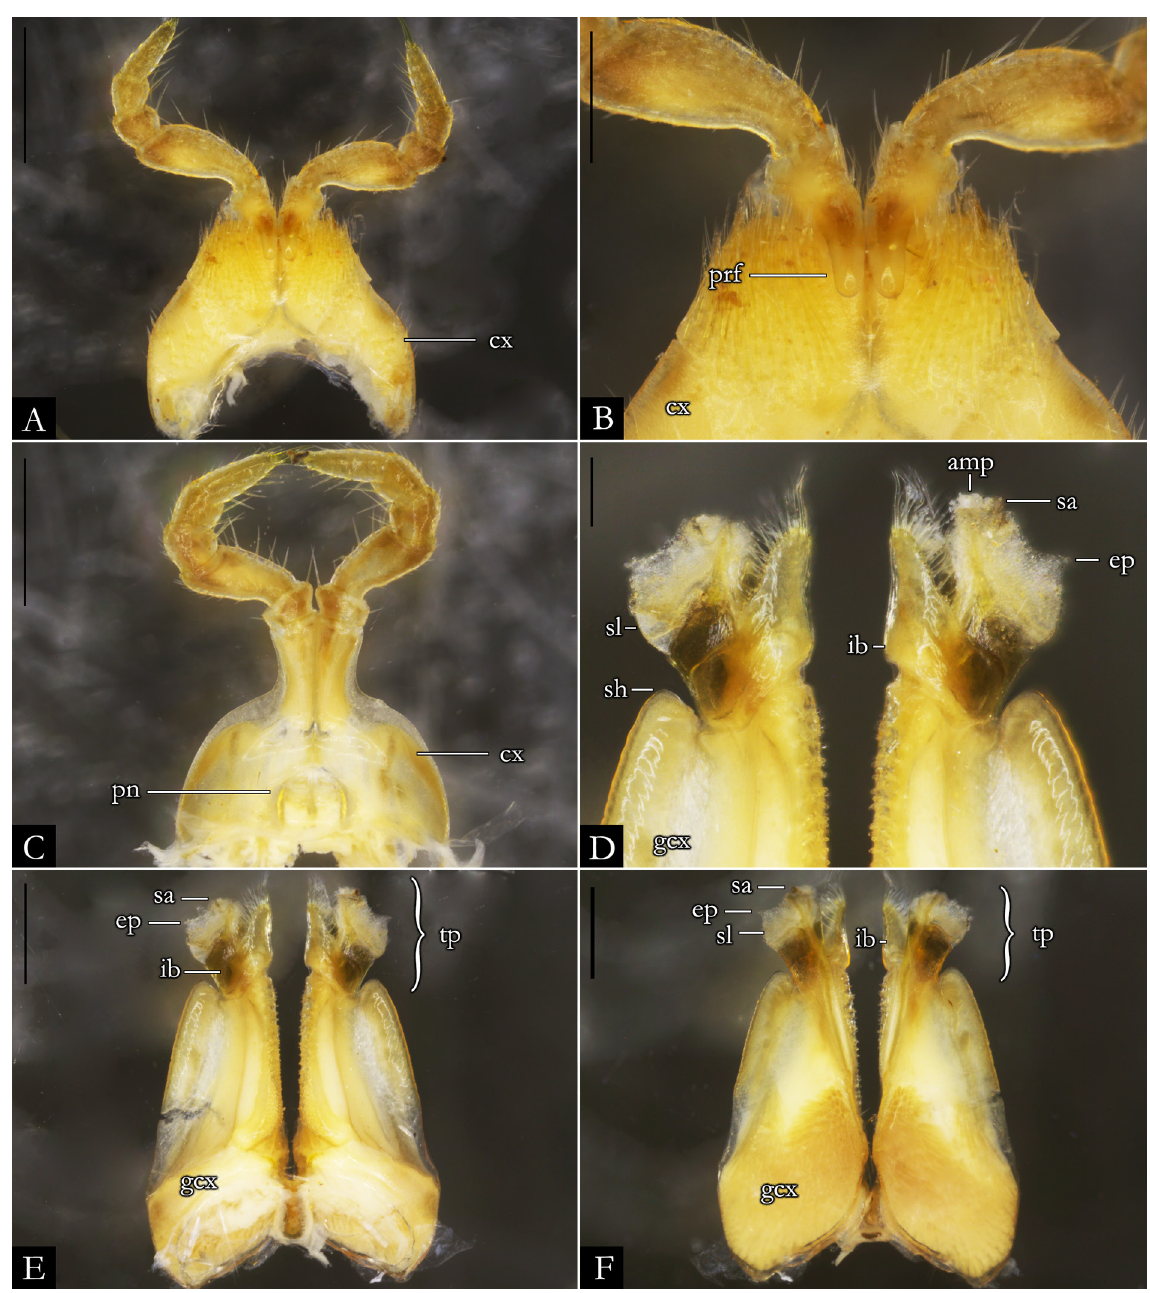
Fig. 84. Pseudonannolene longicornis (Porat, 1888), ♂ (IBSP 3734). A . First leg-pair. B . Detail of prefemur. C . Second leg-pair. D . Detail of telopodites, in anal view. E . Gonopods, in anal view. F . Gonopods, in oral view. Abbreviations: see Material and methods. Scale bars: A, E–F = 0.5 mm; B–D = 0.2